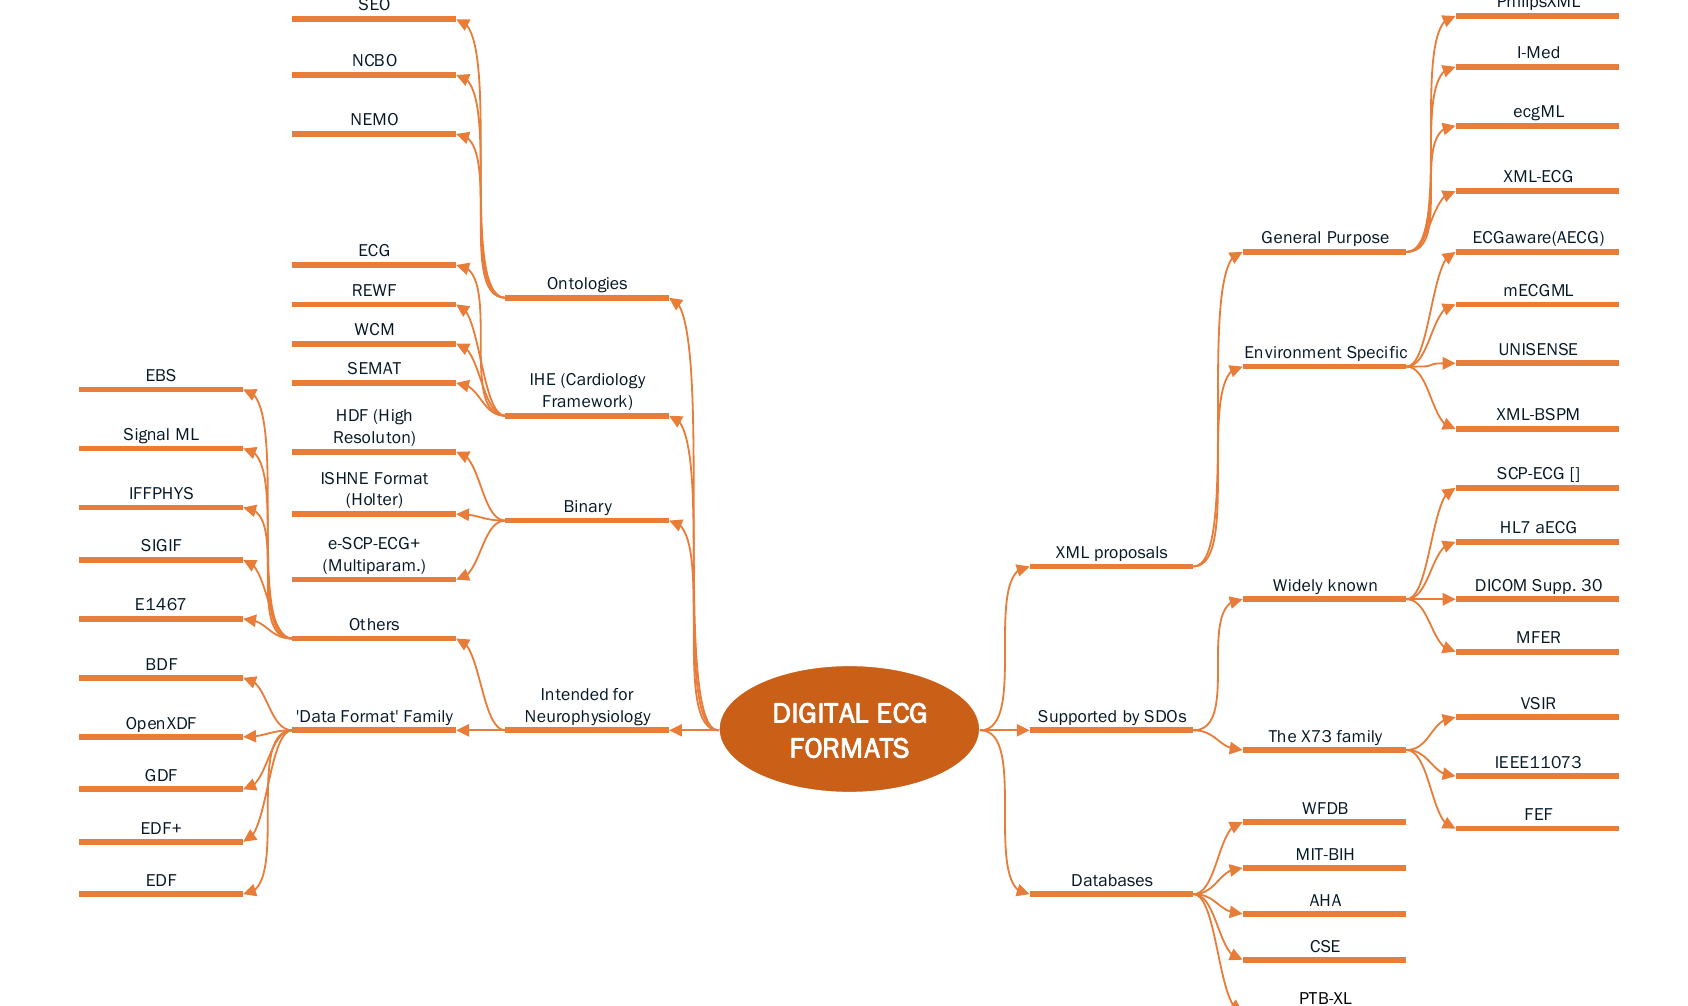
Figure 5. Existing digital formats based on